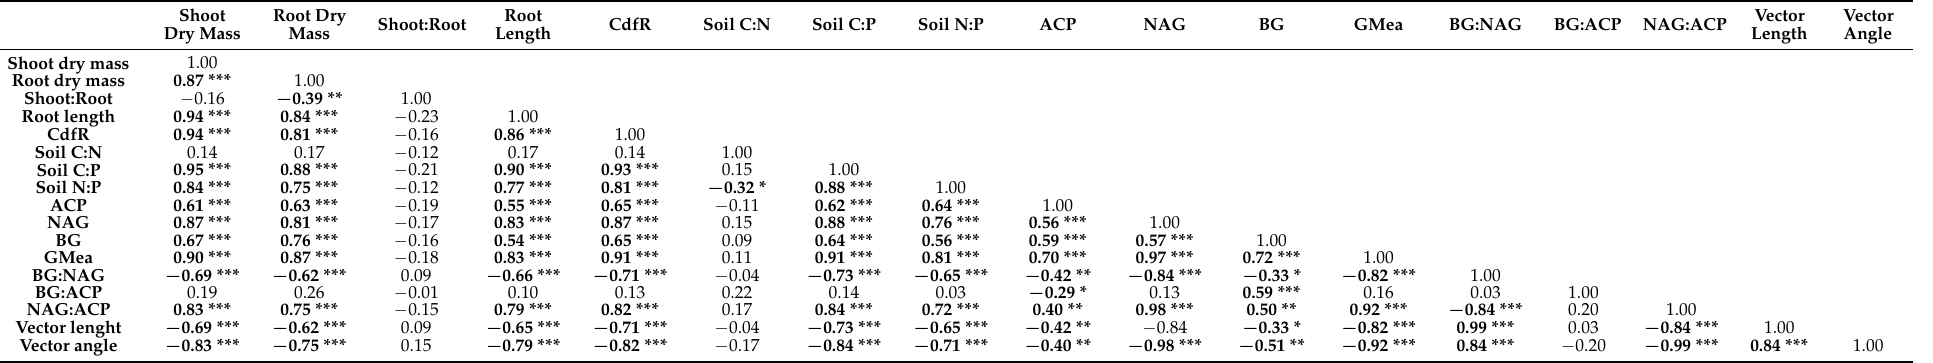
Vector Vector Length